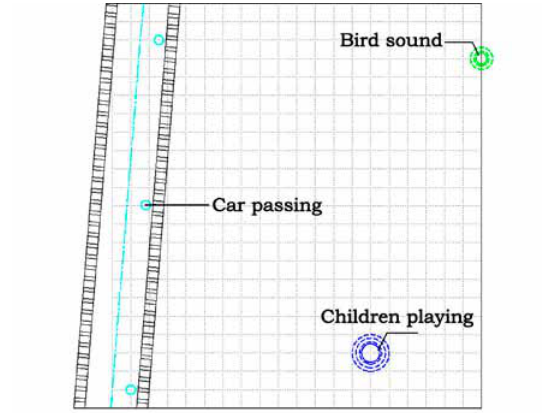
Fig. 8. Sound distributions in the hypothetic square